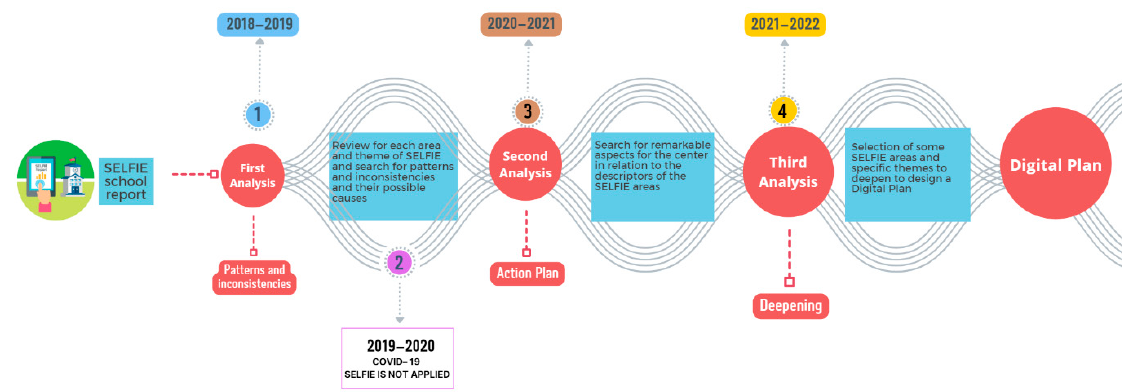
Figure 1. Phases of evaluation and cycles of improvement.